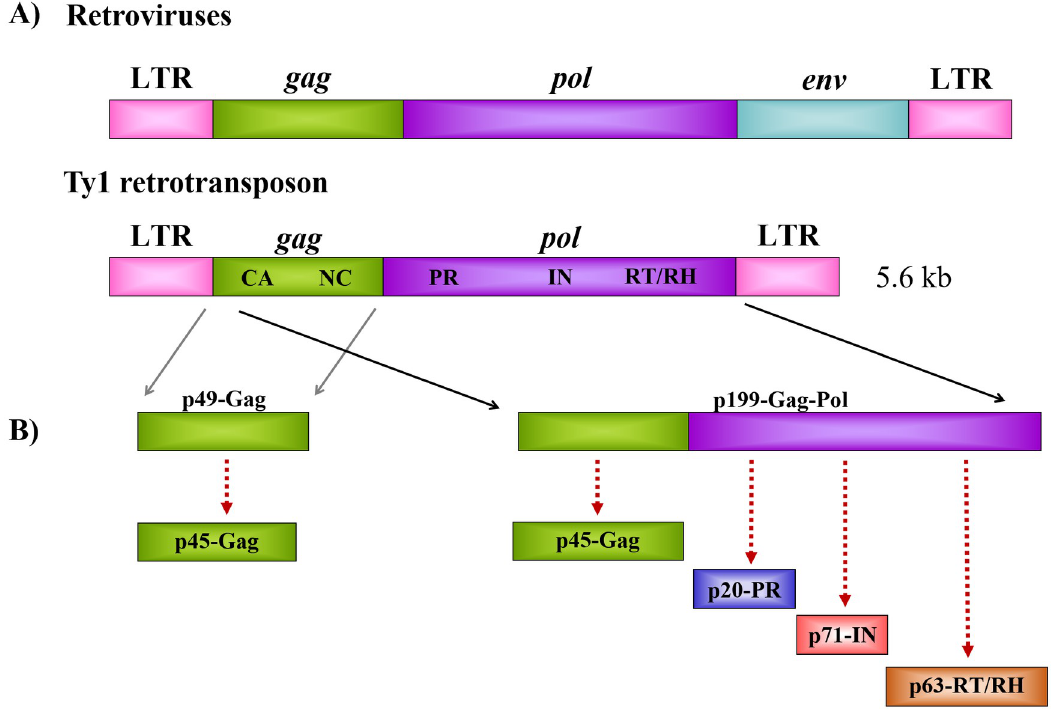
Fig 1. Genome organization of retroviruses and Ty1 retrotransposon. (A) Schematic representations of retroviral and Ty1 retrotransposon genomes are shown. (B) Proteins translated from gag and gag-pol ORFs are shown. Red dashed lines indicate polyprotein processing by Ty1 PR. Numbers denote molecular weights of the protein